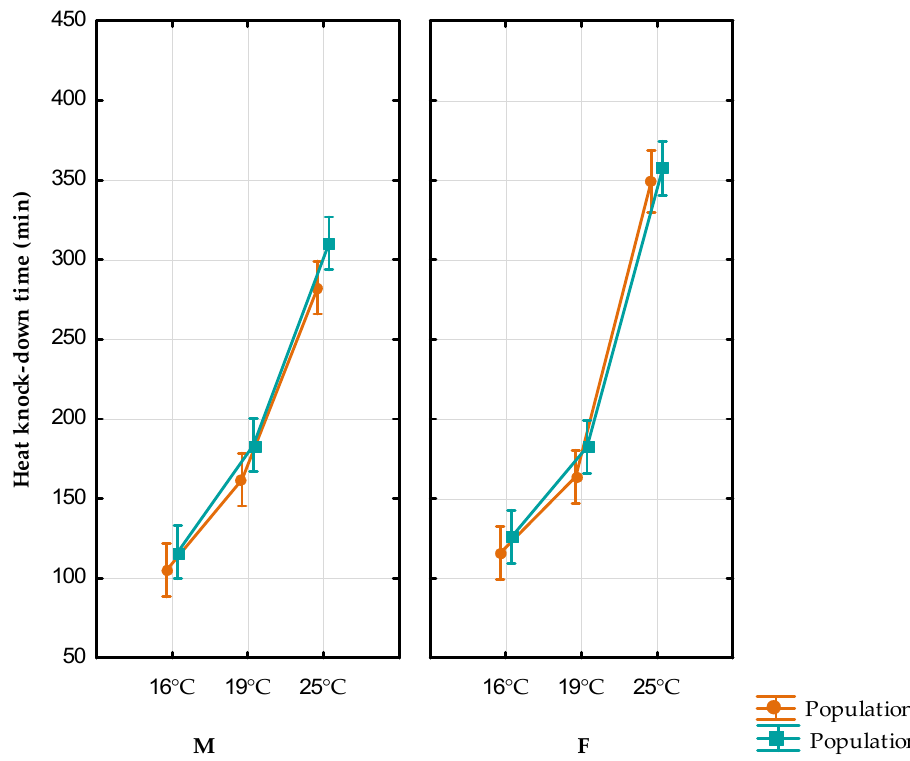
Figure 2. Results of full factorial GLM analysis of heat knock-down resistance with fixed factors population, rearing temperature, and sex. Vertical bars denote 0.95 confidence interval. M—males; F—females; L—population originating from lower altitude; H—population originating from a higher altitude. This Figure was previously published in Proceedings of the 1st International Electronic Conference on Entomology, 1–15 July 2021, MDPI: Basel, Switzerland, doi:10.3390/IECE-10532.